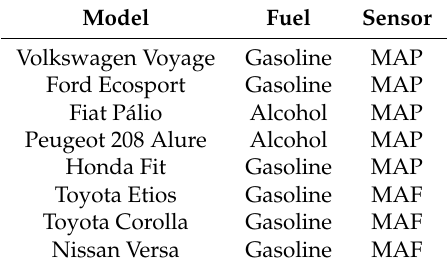
Table 5. Vehicle